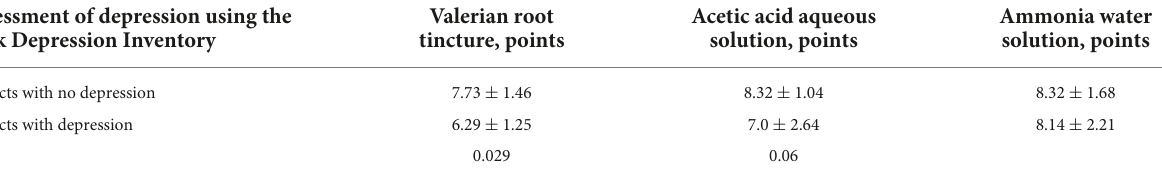
TABLE 6 Olfactory thresholds depending on the presence or absence of depression after recovery from COVID-19. Assessment of depression using the Beck Depression